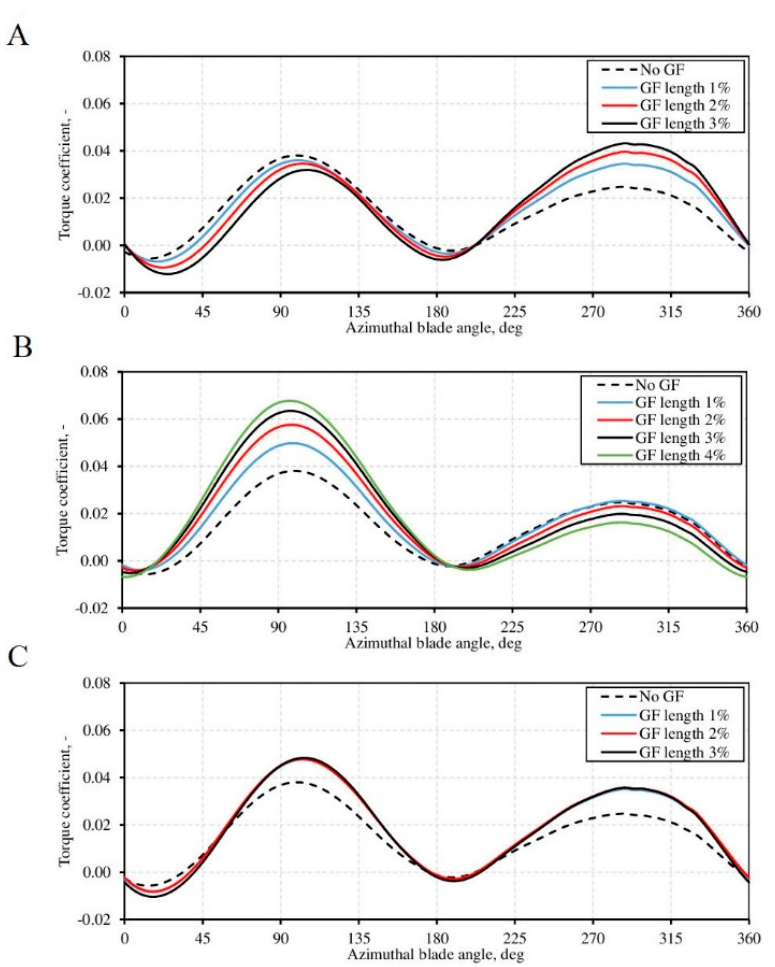
Figure 13. ( A ) Outward pointing one-sided, ( B ) inward pointing one-sided, and ( C ) fish tail Gurney flap length influence on the torque distribution in function of turbine position.